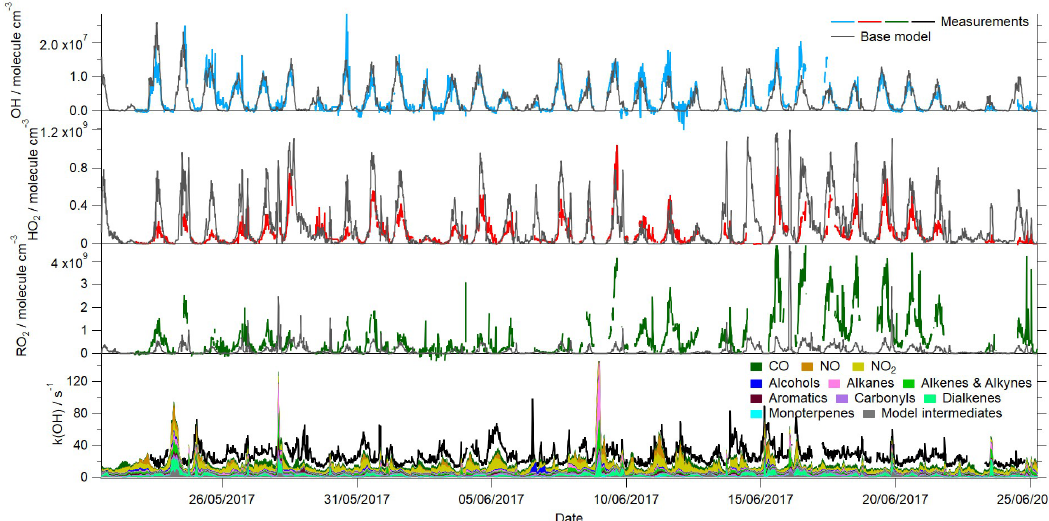
Figure 2. Time series of the measured and modelled OH, HO 2 , total RO 2 and OH reactivity during the campaign.